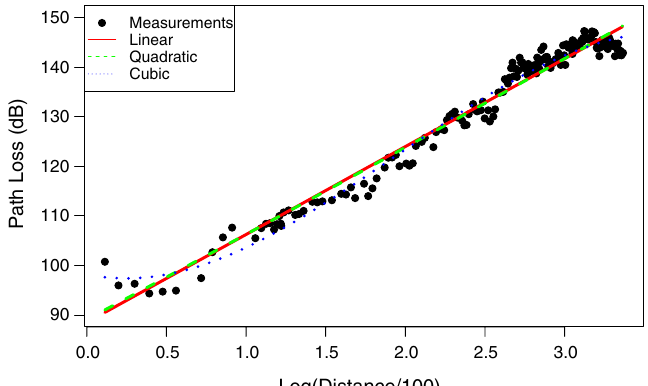
Fig. 3 Relationship between path loss and logarithm of